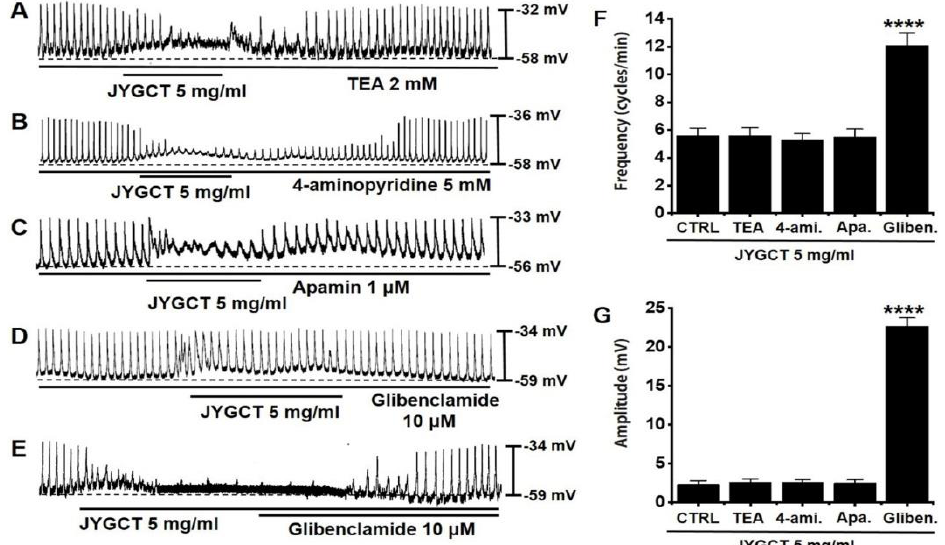
Figure 2. Effect of various K+ channel blockers on the inhibition of pacemaker potential by JYGCT in the ICC. ( A ) Pretreatment with TEA had no effect; ( B ) 4-aminopyridine did not affect the inhi- bition by JYGCT; ( C ) Apamin did not affect the pacemaker potential inhibition induced by JYGCT; ( D ) Glibenclamide blocked the pacemaker potential inhibition by JYGCT; ( E ) The suppression of pacemaker potential by JYGCT was restored by glibenclamide; ( F , G ) Summary of the inhibitory fre- quency and amplitude effects of pretreatment with TEA, 4-aminopyridine, apamin or glibenclamide. Bars represents the mean ± SE. **** p < 0.0001. JYGCT: Jakyakgamcho-tang; CTRL: control; TEA: tetraethylammonium; 4-amino: 4-aminopyridine; Apa: apamin; Gliben: